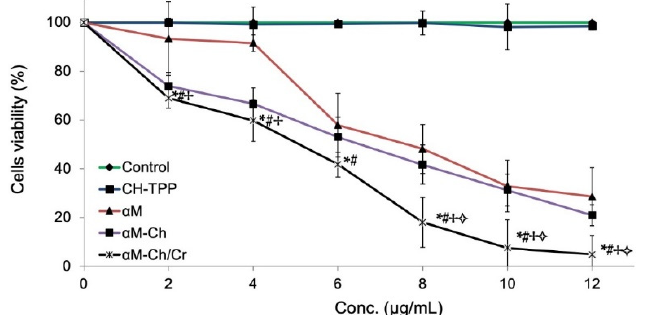
Figure 6. In vitro cytotoxicity of α -mangostin, α M-Ch, and α M-Ch/Cr in MCF-7 cells based on the MTT assay. Data represent mean ±SD. * p < 0.05, compared to the control. # p < 0.05, compared to the CH-TPP. ✢ p < 0.05, compared to the α M. ✧ p < 0.05, compared to the α M-Ch.